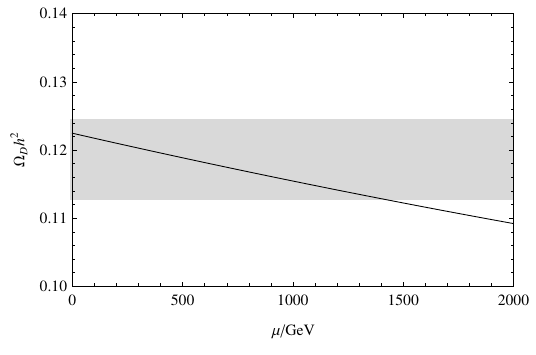
Figure 2 . The relic density versus (cid:22) .